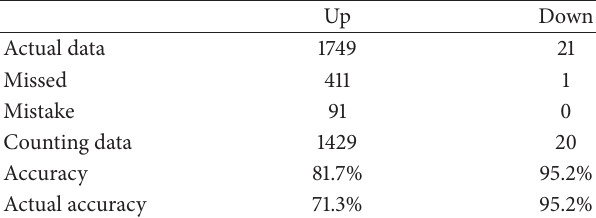
Figure 21: Y AXIS MIN threshold-curve figure (see (12)). Table 7: Experimental results with fixed threshold.